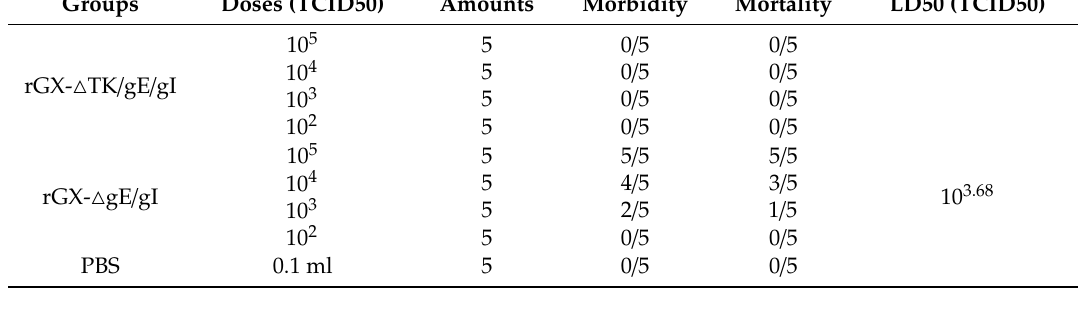
Table 2. Outcome of infection with rGX △ TK/gE/gI and rGX △ gE/gI in mice.